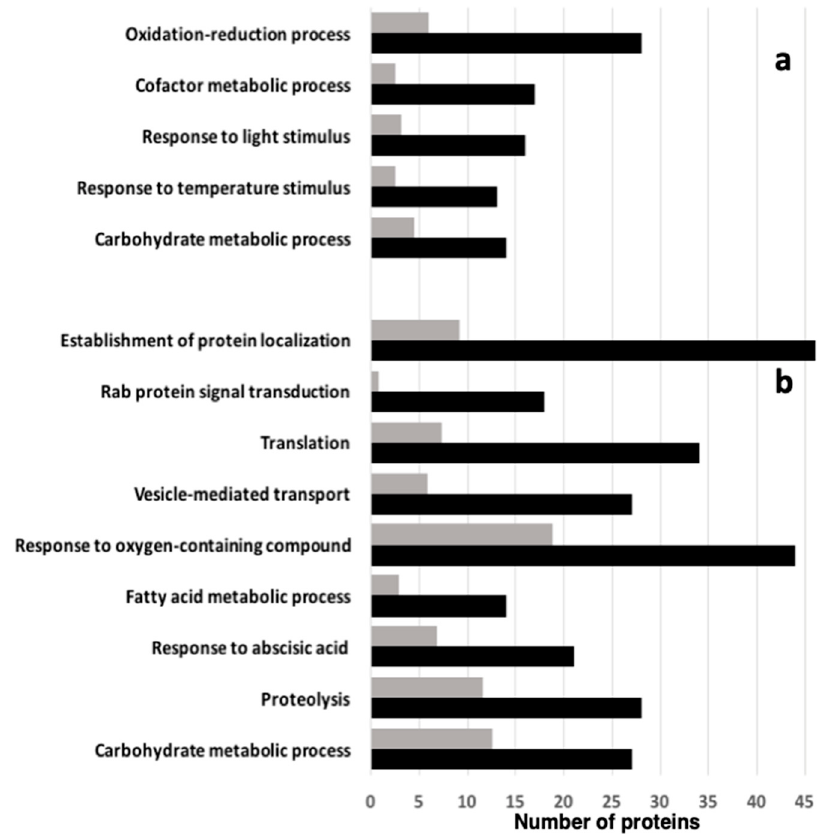
Figure 3. Gene ontology (GO) term enrichment analysis of the selected 442 differentially abundant proteins in vps29 dry seeds in comparison with Col-0 seeds. ( a ) Overrepresented GO terms for 115 proteins that were up-accumulated in Col-0 dry seeds. ( b ) Overrepresented GO terms for 327 proteins that were up-accumulated in vps29 dry seeds. Data from PANTHER overrepresentation test (http://www.geneontology.org); Arabidopsis thaliana GO database released 1 June 2018. Black bars: observed proteins; grey bars: expected result from the reference Arabidopsis genome.